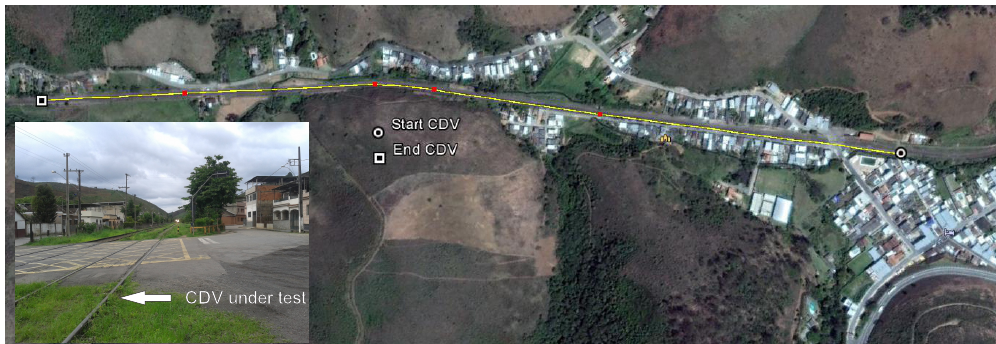
Figure 12. Satellite image of the track circuit under test from the MRS railway network, located at Ewbank da Câmara, MG,